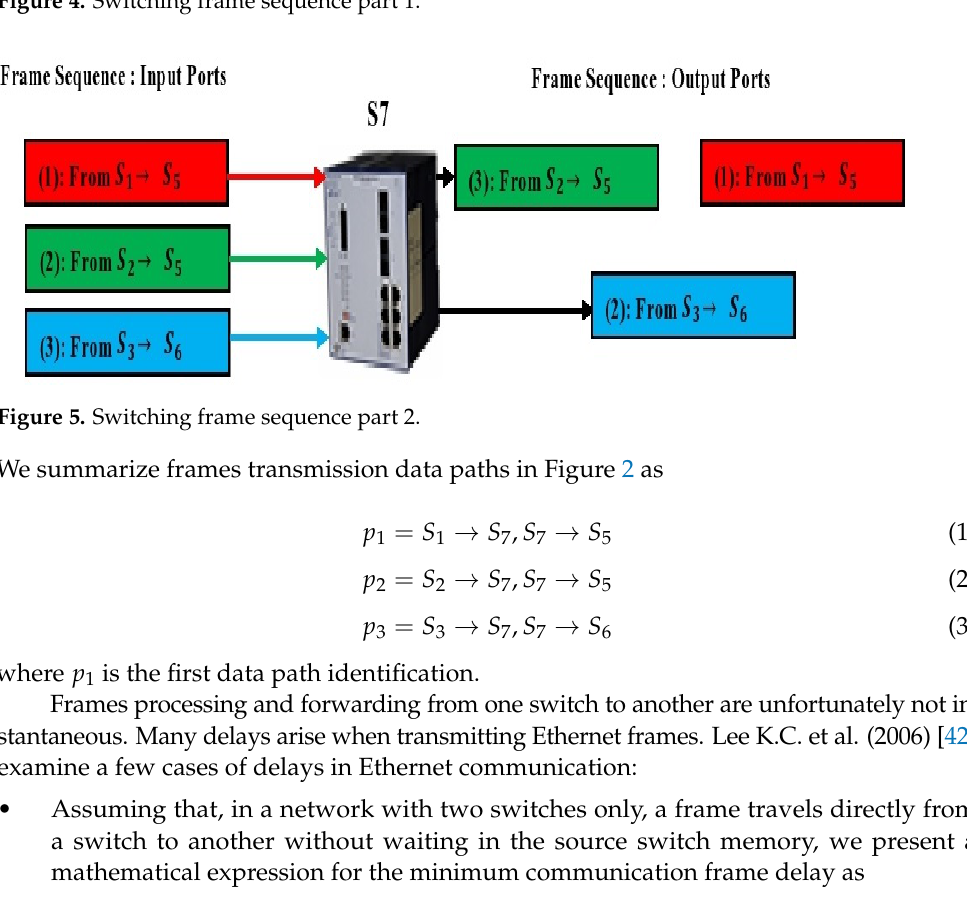
Figure 4. Switching frame sequence part 1.